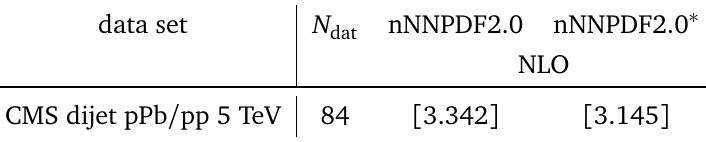
Table 2: The χ 2 per data point calculated for the pPb / pp CMS 5 TeV spectra using the new proton baseline nNNPDF2.0 ∗ ( 1 p ) and the nNNPDF2.0 lead nuclear PDF at NLO. Both values are enclosed in square brackets as the data set is not included in the fit.